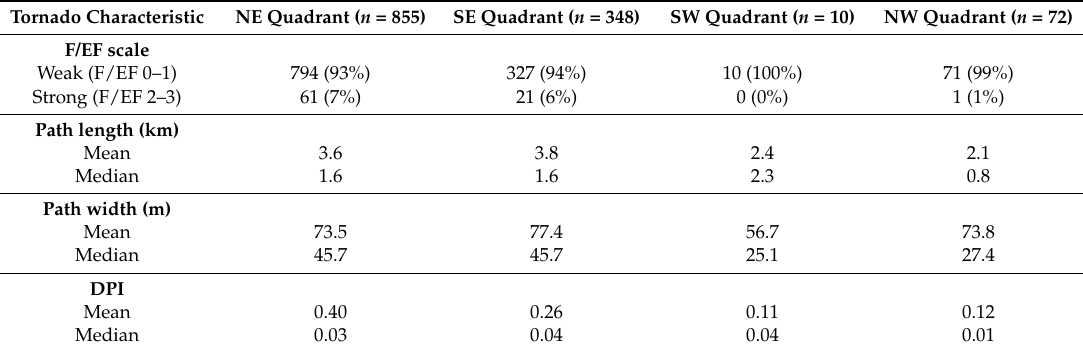
Table 5. Descriptive statistics for the northeast (NE), southeast (SE), southwest (SW), and northwest (NW) quadrants.